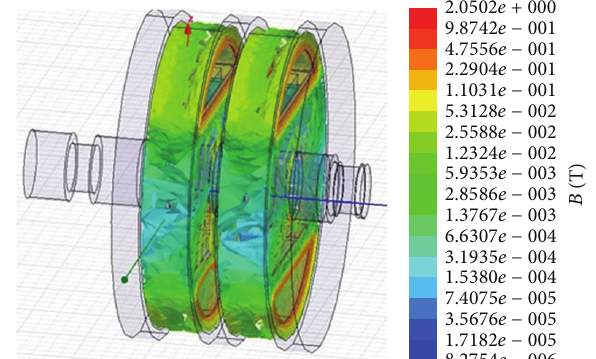
Figure 5: 3D simulated result of magnetic induction